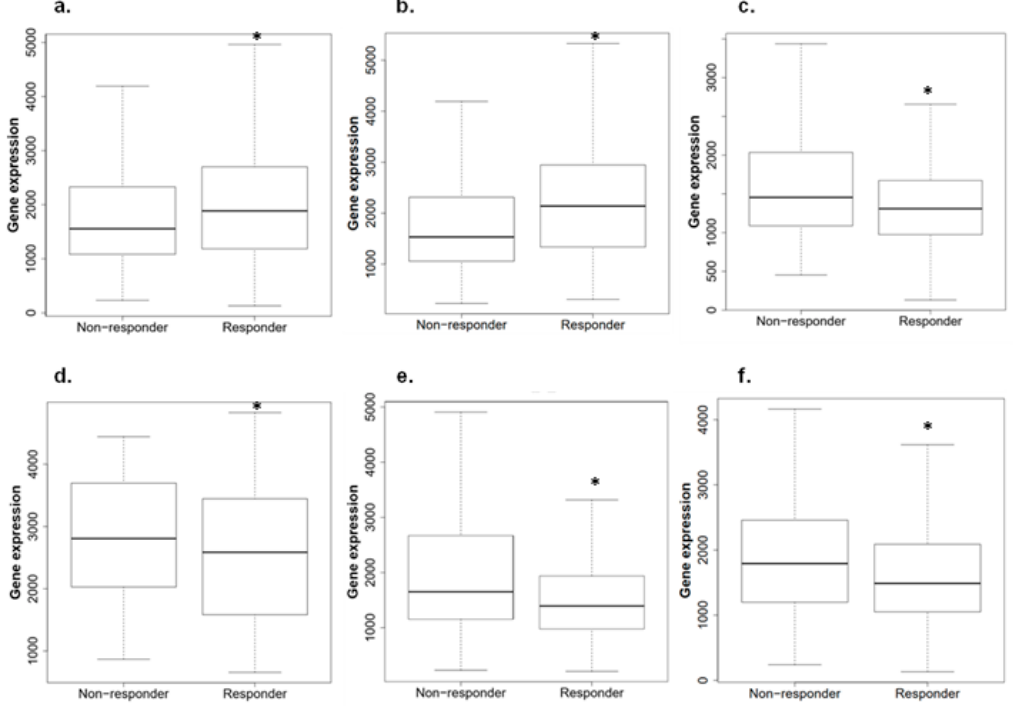
Figure 6. Breast tumor ACBD3 expression in patients when divided by response or non-response to therapies. ( a ) ACBD3 expression in breast chemotherapy responders and non-responders;